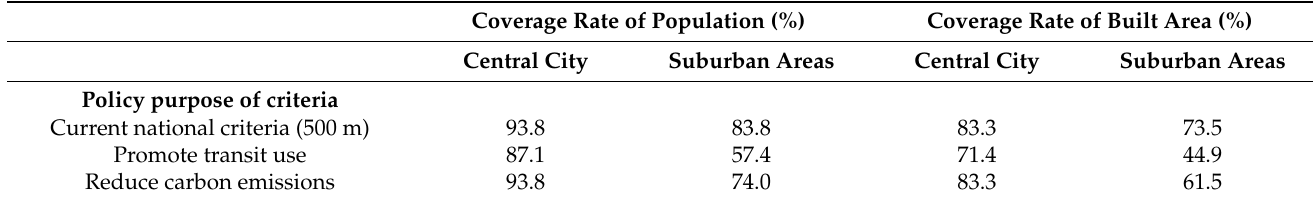
Figure 4. Regions affected by bus stop proximity from different policy aspects. Table 6. Bus stop coverage under different